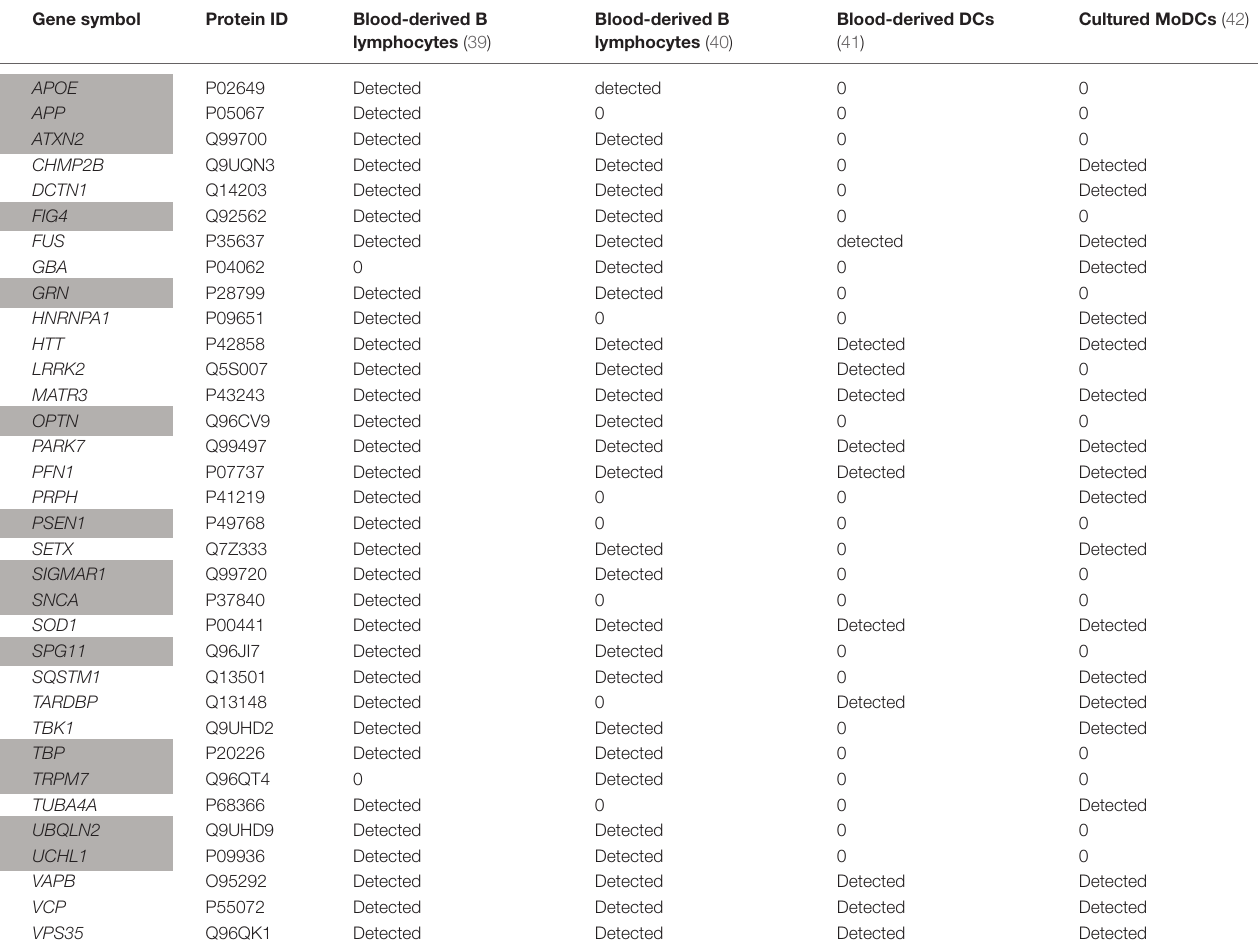
TABLE 1 | Expression patterns of human neurodegeneration-associated proteins in B-cells vs. dendritic